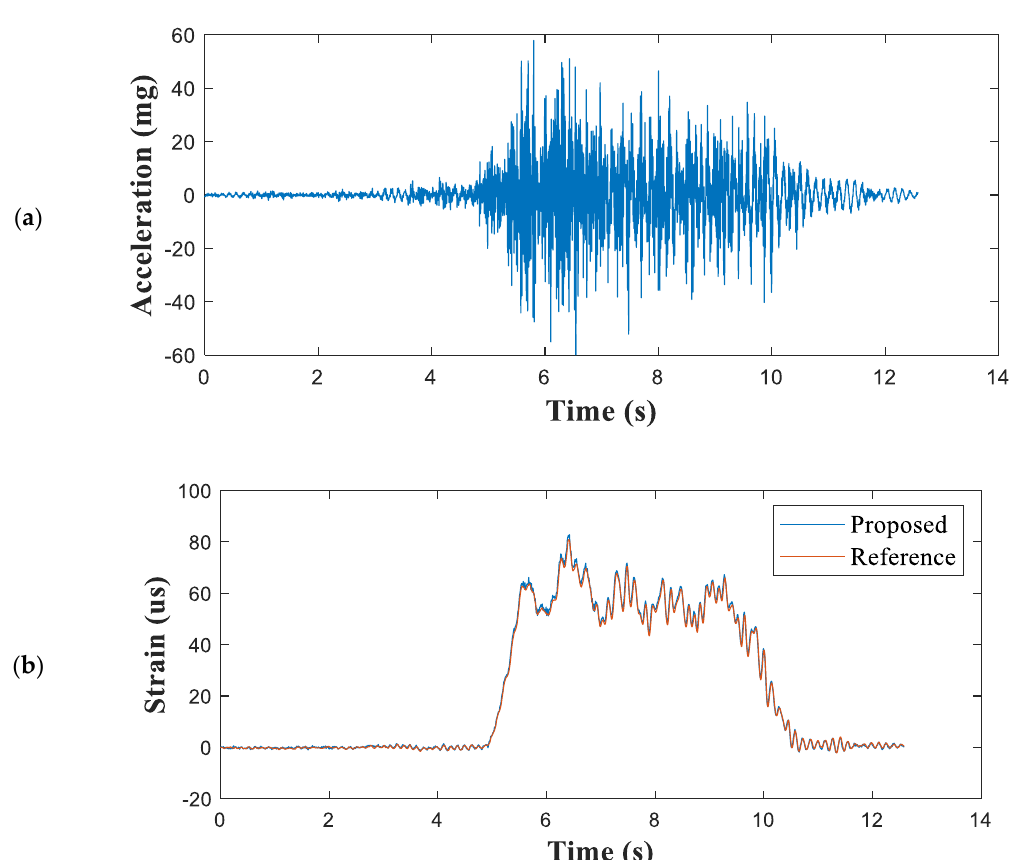
Figure 8. Measured structural responses of the Keukrak Bridge: ( a ) vertical acceleration and ( b ) strains at mid-span point.